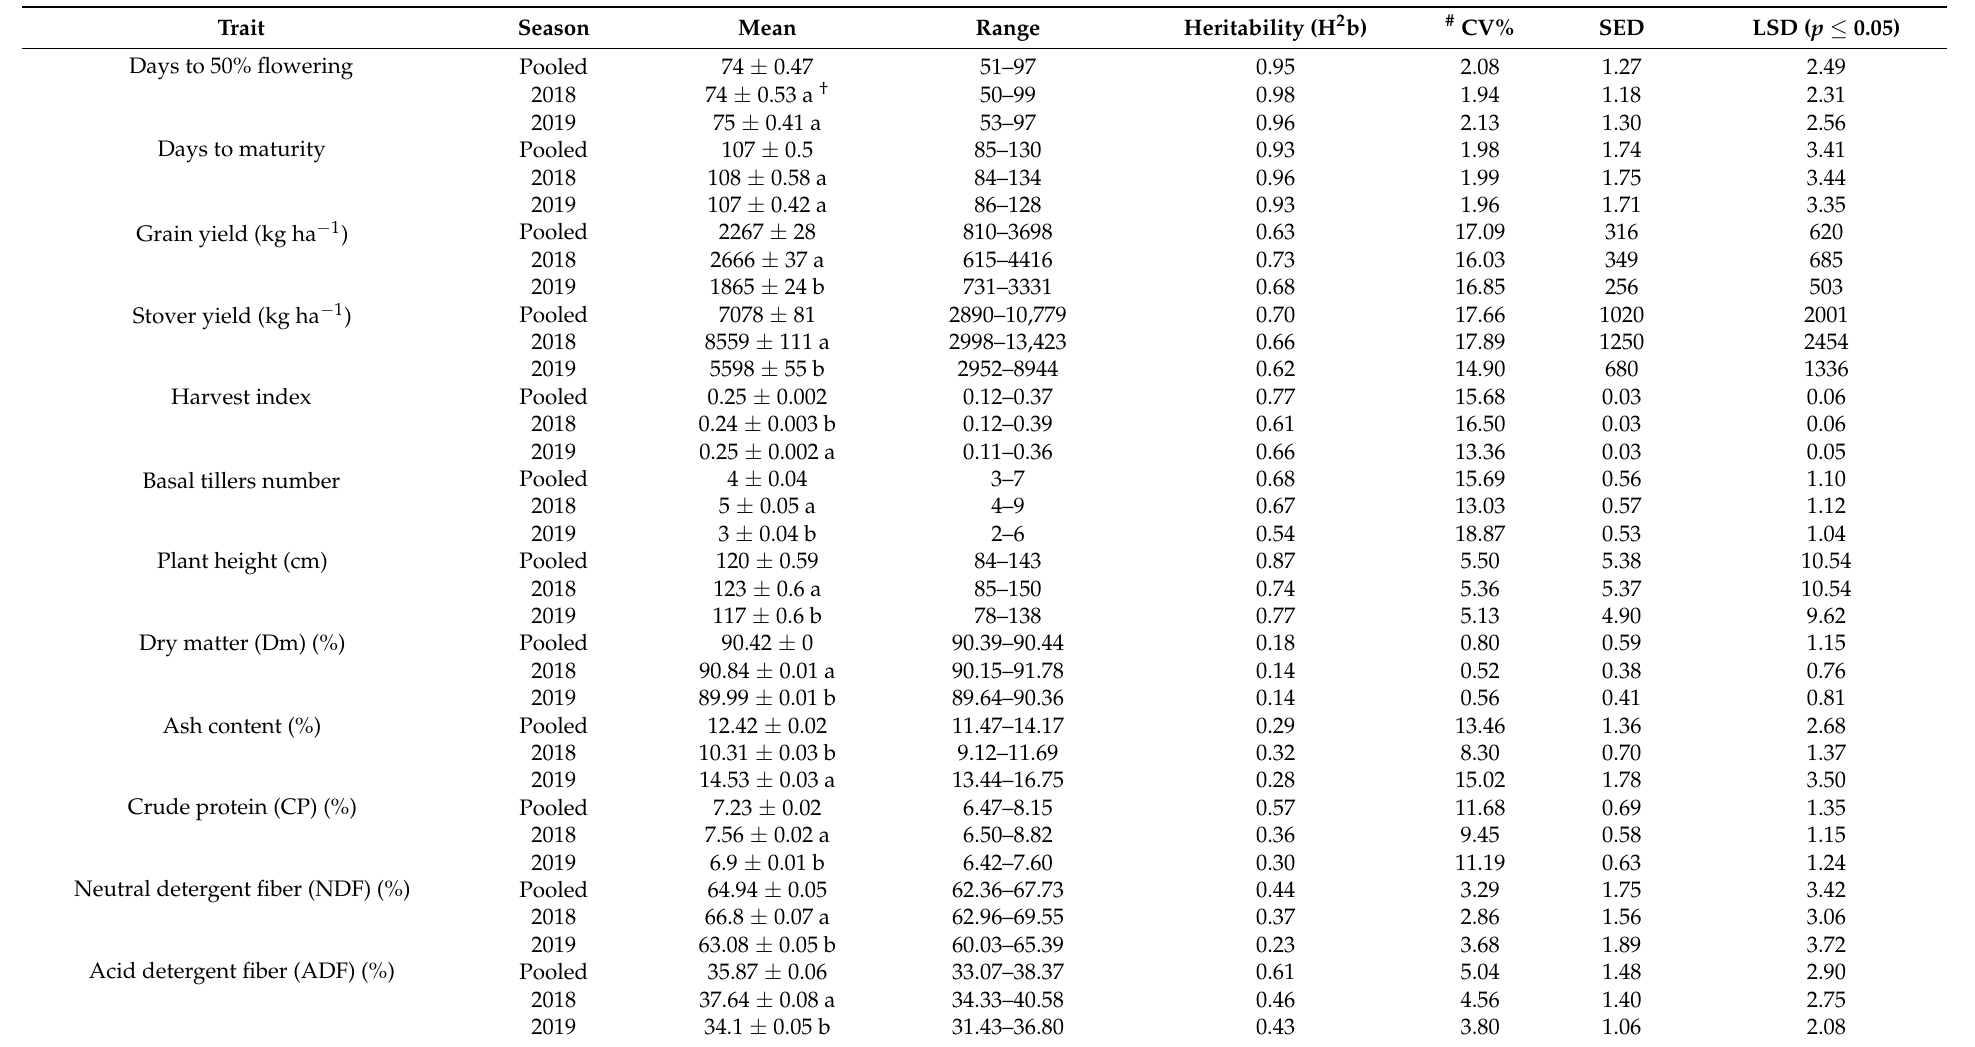
Table 2. Mean, range, and heritability on agronomic and forage quality traits of 314 finger millet accessions evaluated in 2018 and 2019 at ICRISAT, Patancheru, India.